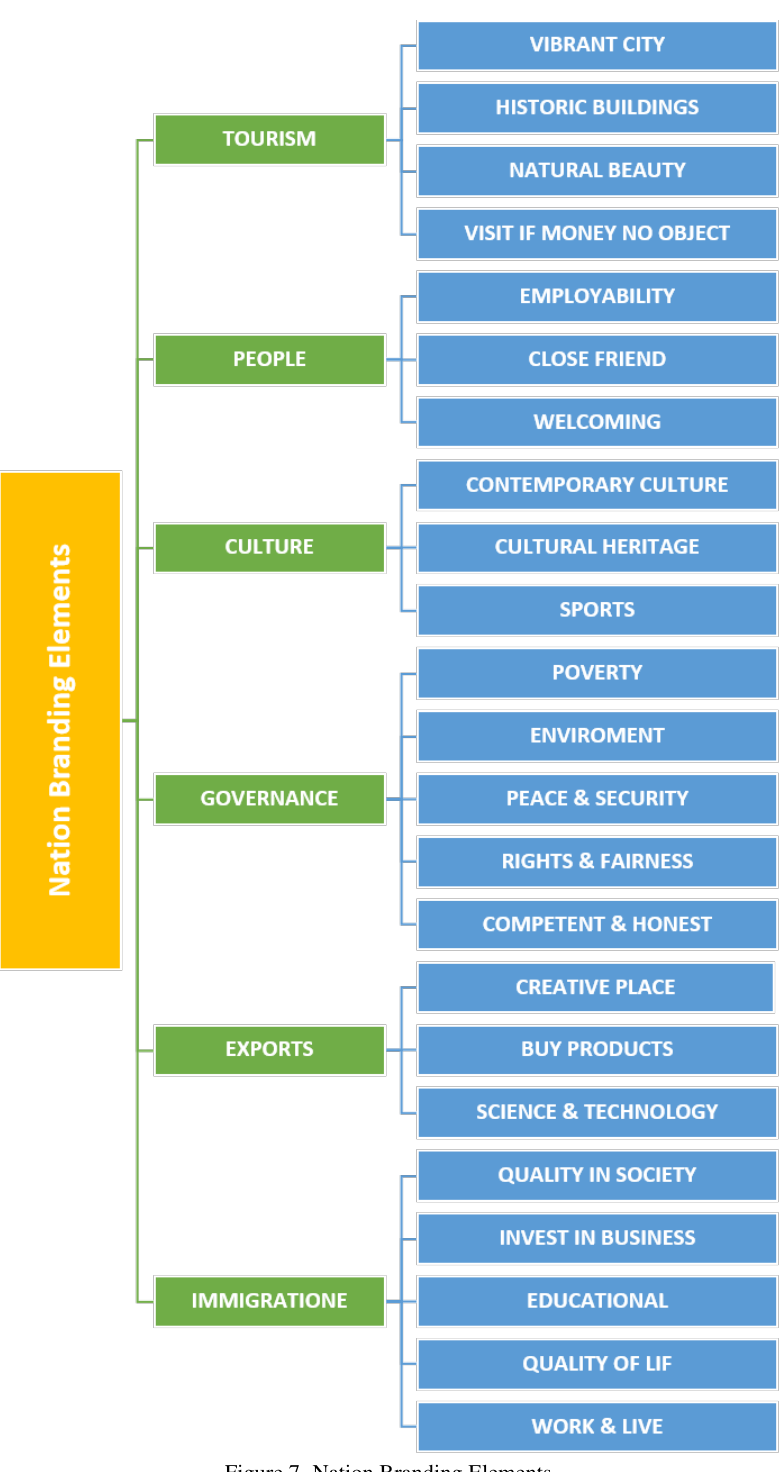
Figure 7. Nation Branding